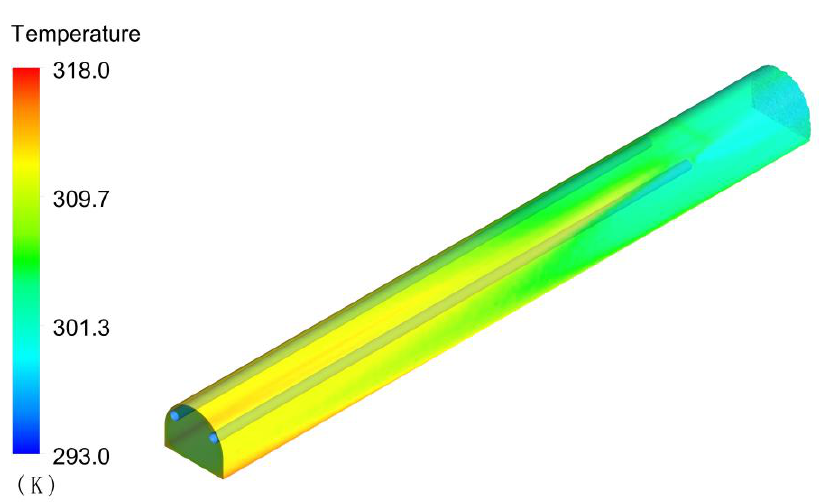
Figure 14. Model 4 roadway temperature side view (x = 0).